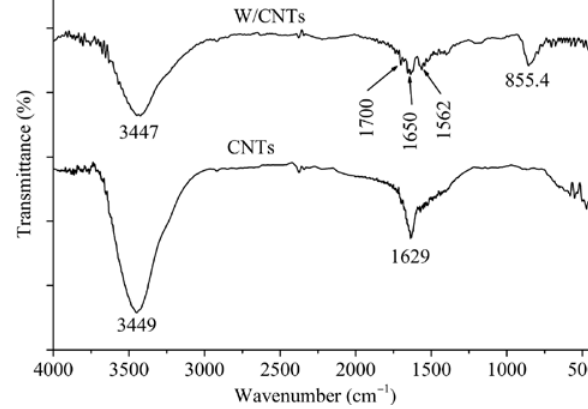
Figure 3: XRD patterns of CNTs and W/CNT.